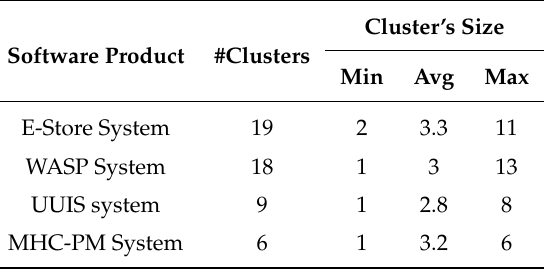
Table 4. Statistical information of the identified clusters for each software product.